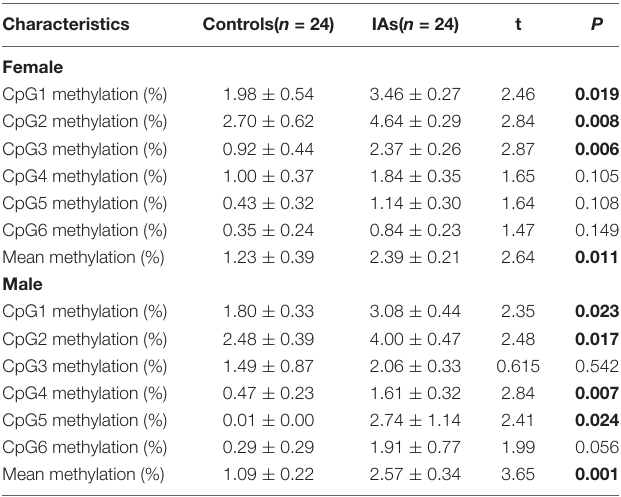
TABLE 3 | Comparison of PTBP1 methylation between two groups according to gender.